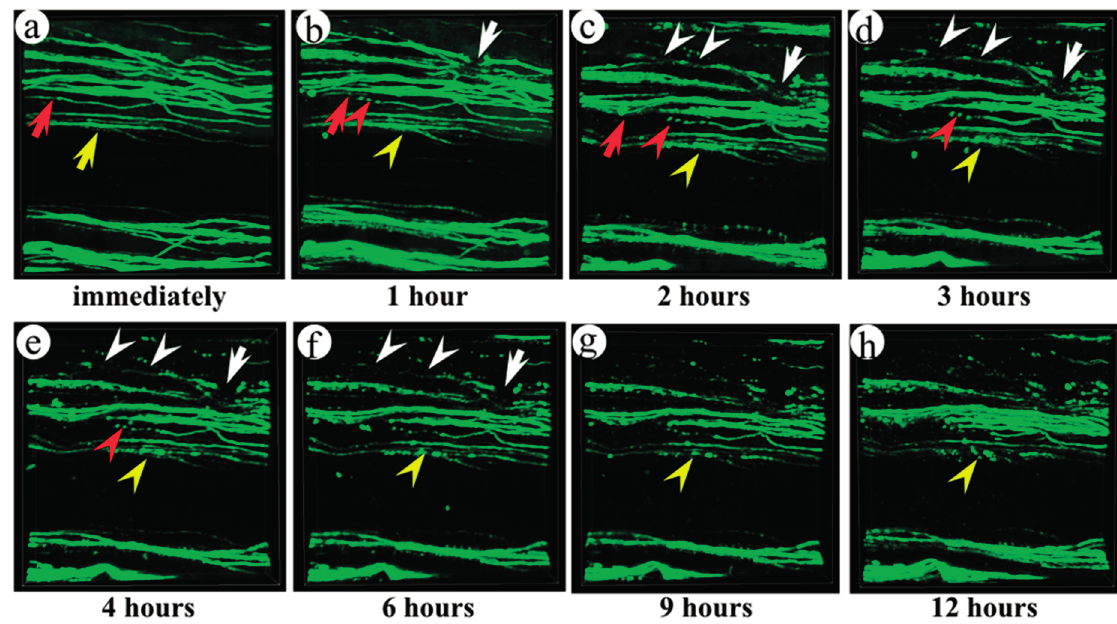
Figure 6. Continuous observation of axon degeneration in the early phase after spinal cord contusion injury using two-photon excitation microscopy. YFP-positive fibers in the injured spinal cord were observed immediately ( a ), 1 h ( b ), 2 h ( c ), 3 h ( d ), 4 h ( e ), 6 h ( f ), 9 h ( g ), and 12 h ( h ) after the injury. The initial contusive injury occurred immediately (see white arrows and red arrows) and then was followed by axonal fragmentation (white and red arrowheads). An injured axon could also become swollen 1–2 h after the injury and then become fragmented (yellow arrowheads). Image acquisition was performed in an area of 509 × 509 μ m at seconds per frame. A three-dimensional volume-rendering image was constructed using the z-stack images. Left side is cranial, and right side is